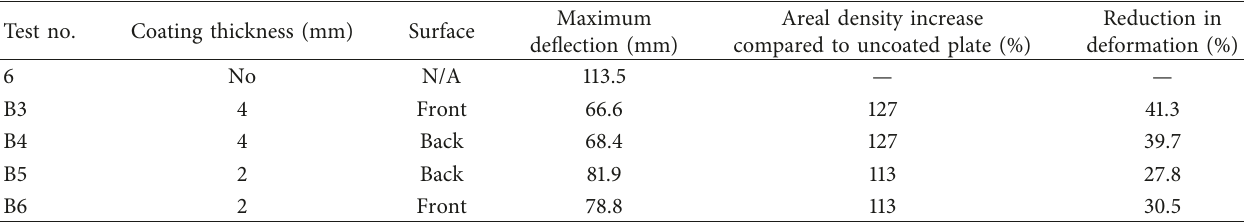
Figure 5: Examples of test plates after test: (a) no rupture (10mm standoff); (b) a crack (8mm standoff); (c) three petals (8mm standoff). Table 6: Results of test plates coated with polyurea at the same